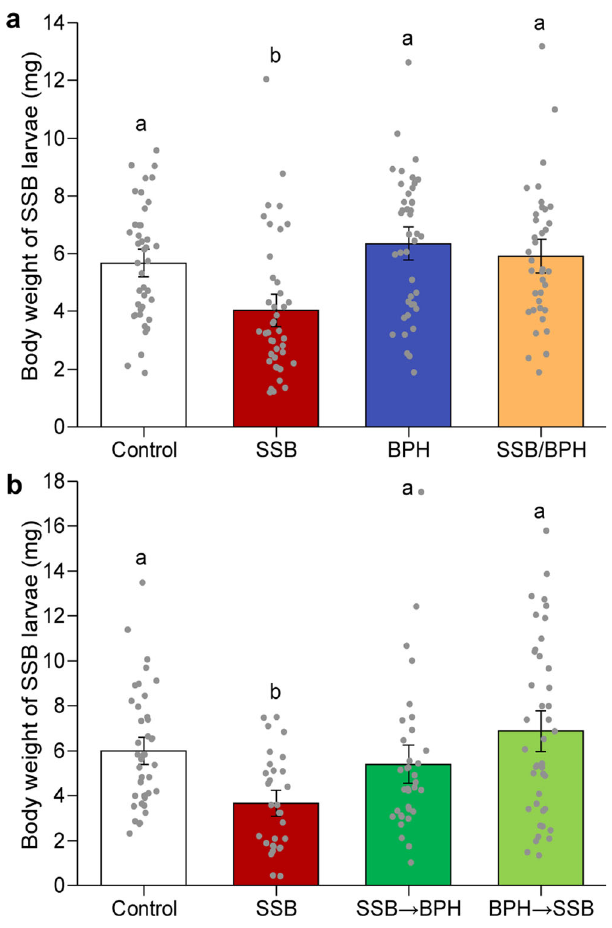
Fig. 1 Weight of SSB larvae after 7 days of feeding on differentially infested rice plants. a Neonates of rice striped stem borer (SSB) were individually placed on rice plants that were either uninfested (Control) ( n = 41), infested by SSB larvae only (SSB) ( n = 46), brown planthopper (BPH) only (BPH) ( n = 41), or both SSB and BPH (SSB/BPH, the two species were simultaneously introduced to the plants) ( n = 37). Exact P- values = 0.0012 (Control vs SSB), 0.16 (Control vs BPH), 0.64 (Control vs SSB/BPH), 4.85e-06 (SSB vs BPH), 3.20e-04 (SSB vs SSB/BPH), and 0.37 (BPH vs SSB/BPH). b Neonates of SSB were individually placed on rice plants that were either uninfested (Control) ( n = 42), infested by SSB only ( n = 30), or both SSB and BPH in sequencing order (SSB → BPH ( n = 34), plants were infested with SSB larvae for 24 h then BPH were added for another 24 h; BPH → SSB ( n = 43), plants were infested with BPH for 24 h then SSB larvae were added for another 24 h). Exact P- values = 0.0023 (Control vs SSB), 0.41 (Control vs SSB → BPH), 0.23 (Control vs and 0.051 (SSB → BPH vs BPH → SSB). Bars indicate mean ± SE. Data were analyzed using two-way analysis of variance followed by least signi fi cant difference (LSD) post-hoc test. Different letters above the bars indicate signi fi cant differences between treatments ( P <